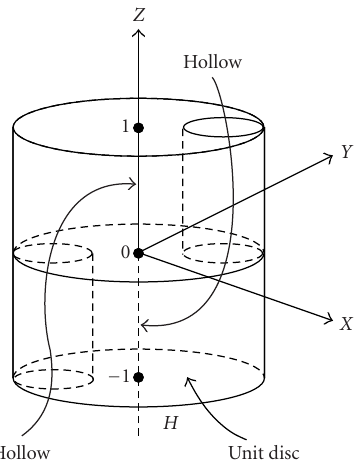
Figure 4.1. A house with two